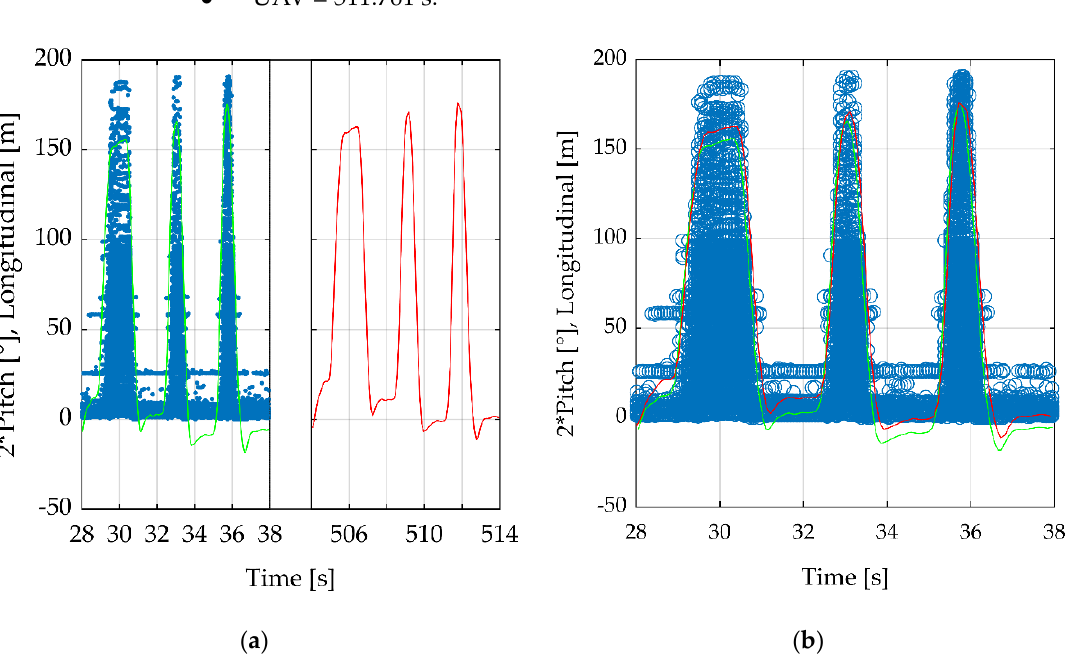
Figure 3. Example of time synchronization of three different sources by aligning their pitch move- ments. ( a ) Radar data (blue) are nearly synchronous with the pitch data of the RPi (green). The UAV pitch data (red) have different times. ( b ) Time-synchronized data.